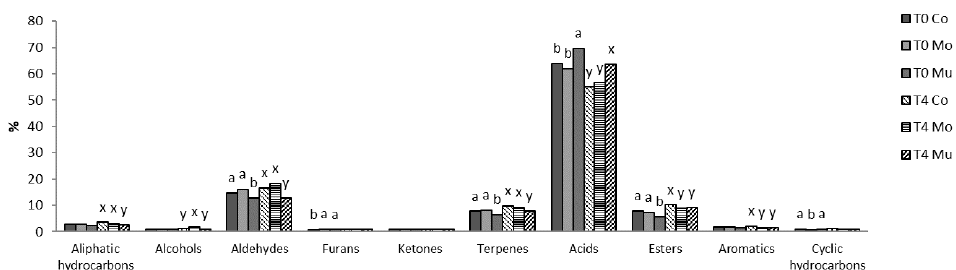
Figure 2. Percentage of families of volatile compounds in dry-cured sausages. Different letters indicate a significant enrichment effect among batches at T0 (a,b) and T4 (x,y). Co: control batch; Mo: batch with added monolayered fish oil microcapsules; Mu: batch with added multilayered fish oil microcapsules; T0: batch sampled before storing; T4: batch sampled after storing for four months.